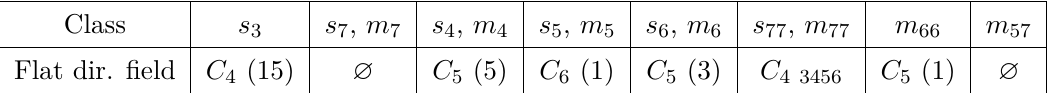
Table 4 . Analogous table to table 3, indicating flat directions for the other 13 classes of [15], for completeness. For s and m , with O placed along internal directions 1234 and 1256, only one 77 77 7 of the three C components is a flat 4